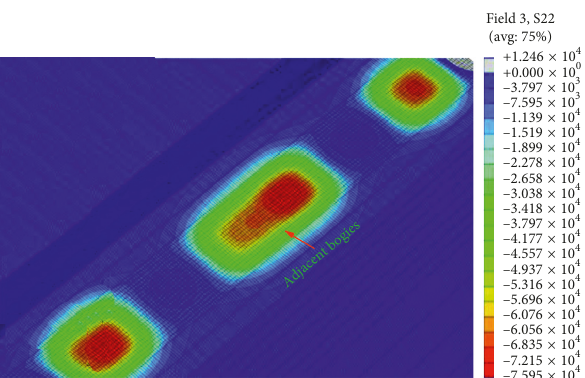
Figure 10: Dynamic stress contour at the bottom of the subgrade bed surface layer.